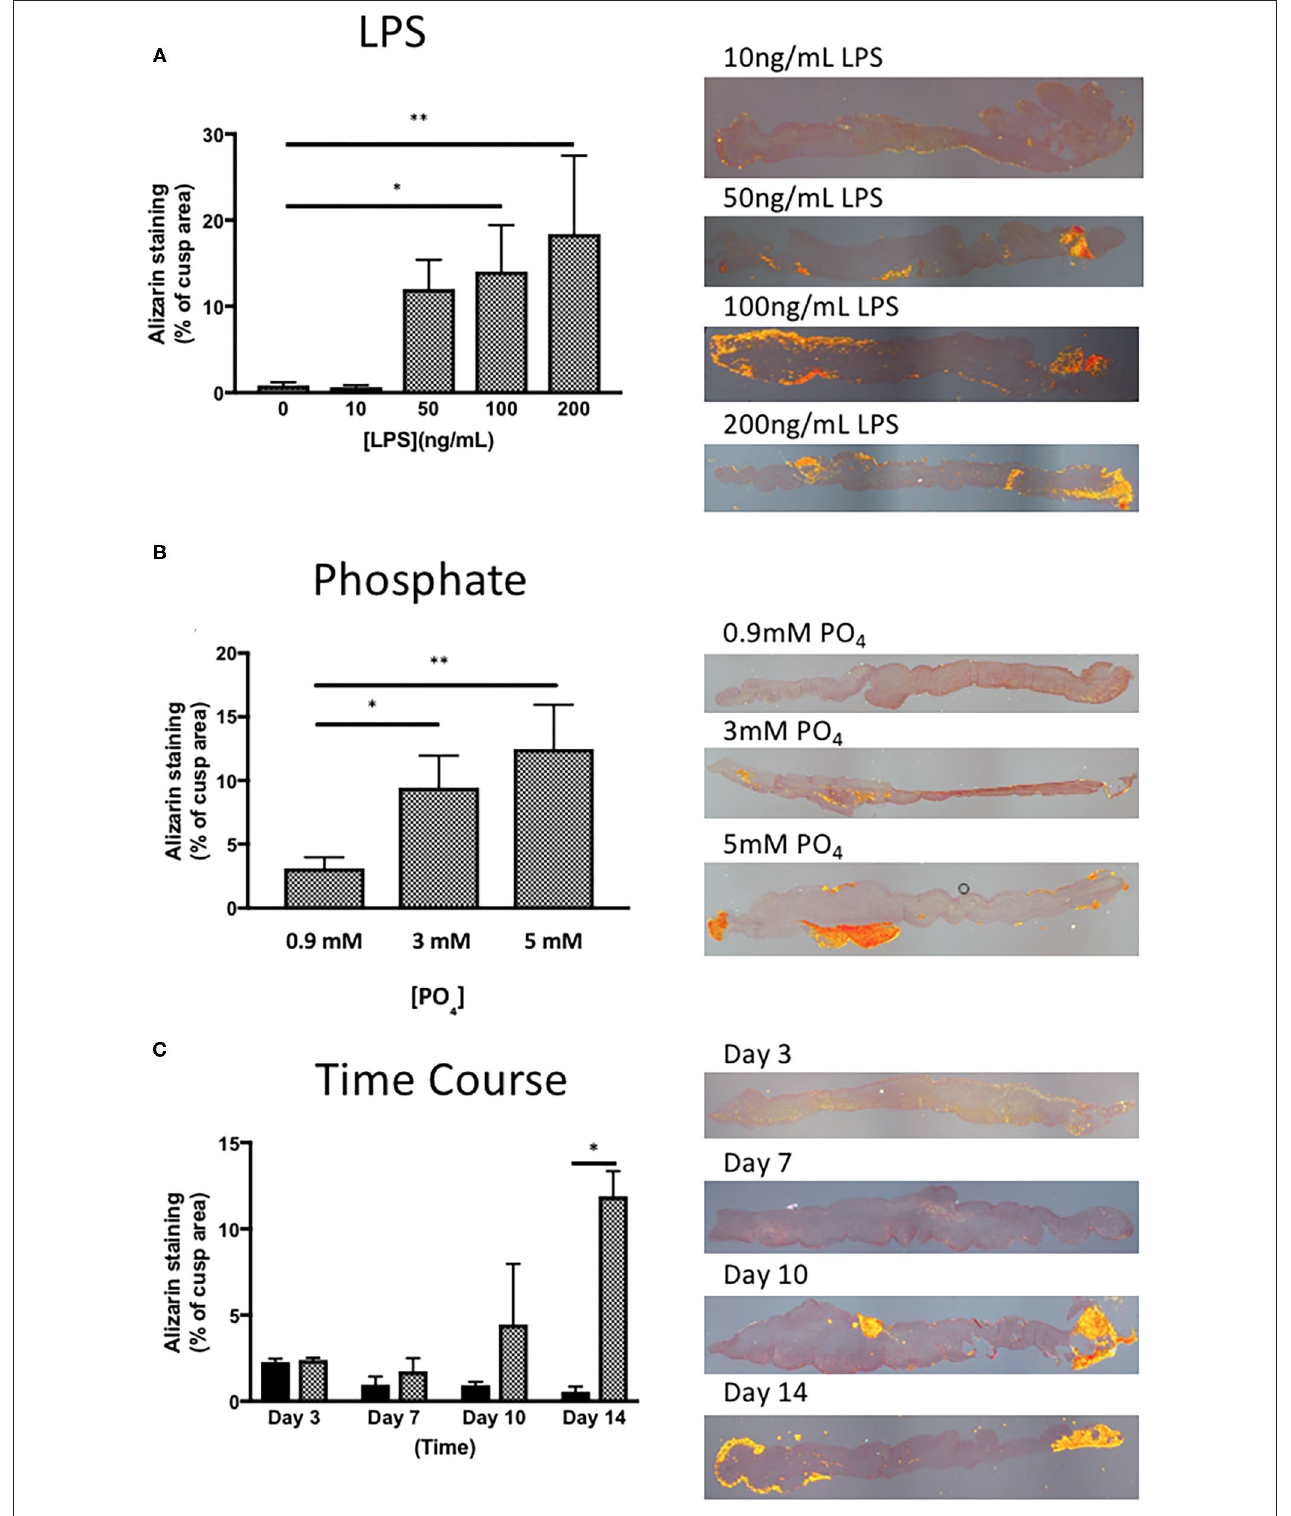
FIGURE 2 | Optimisation of the response of valve leaflets to LPS and phosphate. (A) The effect of LPS concentration on calcium accumulation in porcine aortic valve leaflets in culture for 14 days in the presence of 3mM phosphate (* p = 0.071, ** p = 0.003, ANOVA; n = 3) and representative images of sections stained with